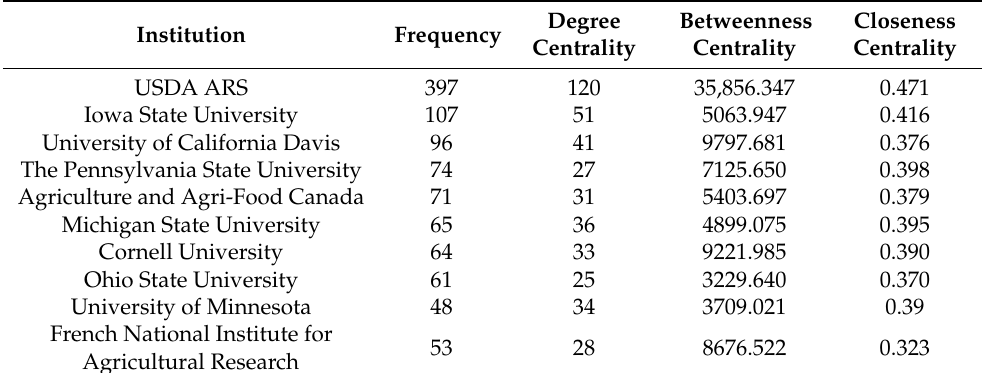
Table 8. Top 10 institutions based on the frequency.